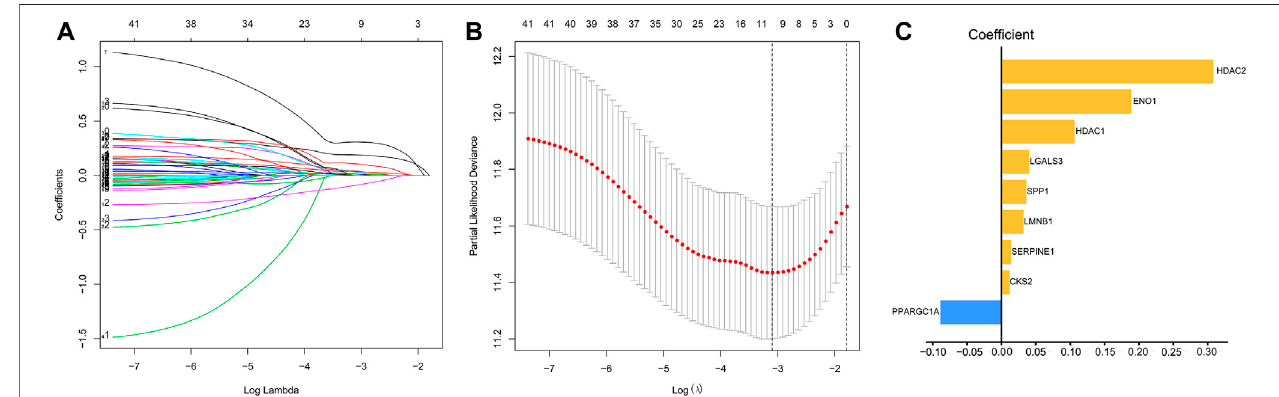
FIGURE 4 | Identi fi cation of EMT risk genes that affect OS in HCC patients in the TCGA dataset. (A, B) . The lasso-Cox regression model was utilized to identify EMT-related gene signature through 10-fold cross-validation. (C) The coef fi cient of the selected EMT risk genes. Notes: EMT, Epithelial-mesenchymal transition; OS, overall survival; TCGA, The Cancer Genome Atlas Program.